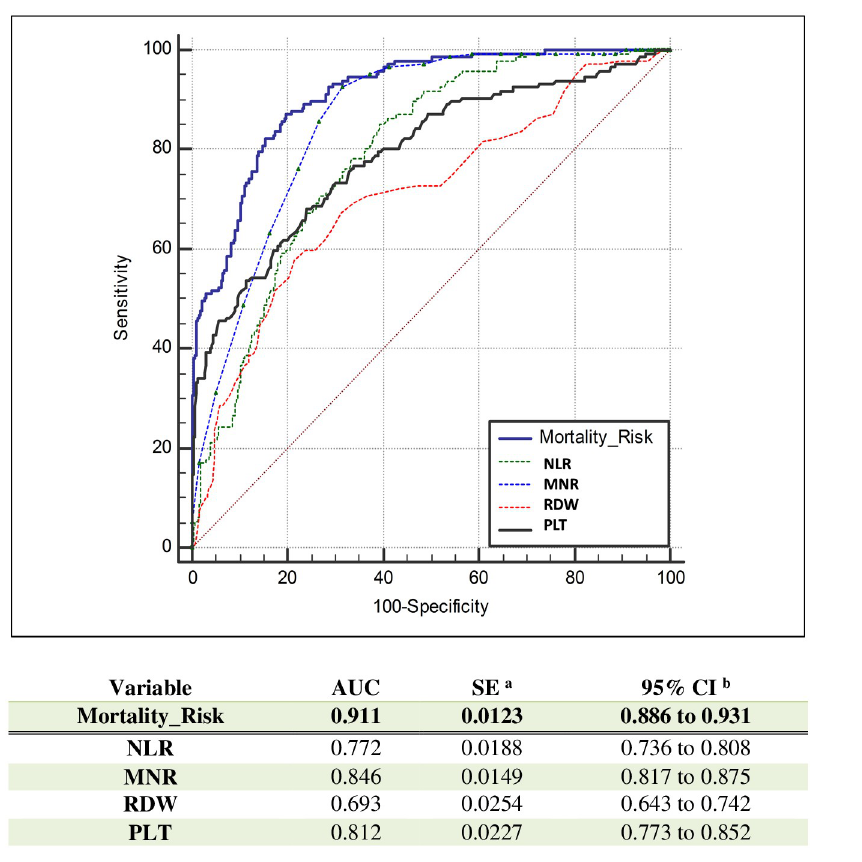
Fig 4. ROC curves of mortality risk and NLR, MNR, RDW,